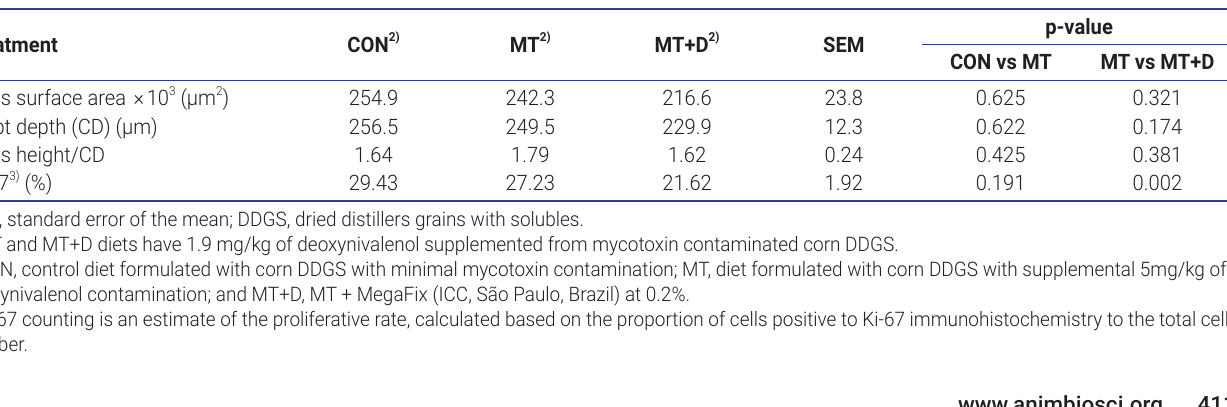
Table 6. Histological measurement from mid-jejunal morphology and immunohistochemistry in weaned pigs consuming diets with (MT 1) ) or without mycotoxins (CON) and diet with mycotoxins and feed additives by the end of week 5 Treatment